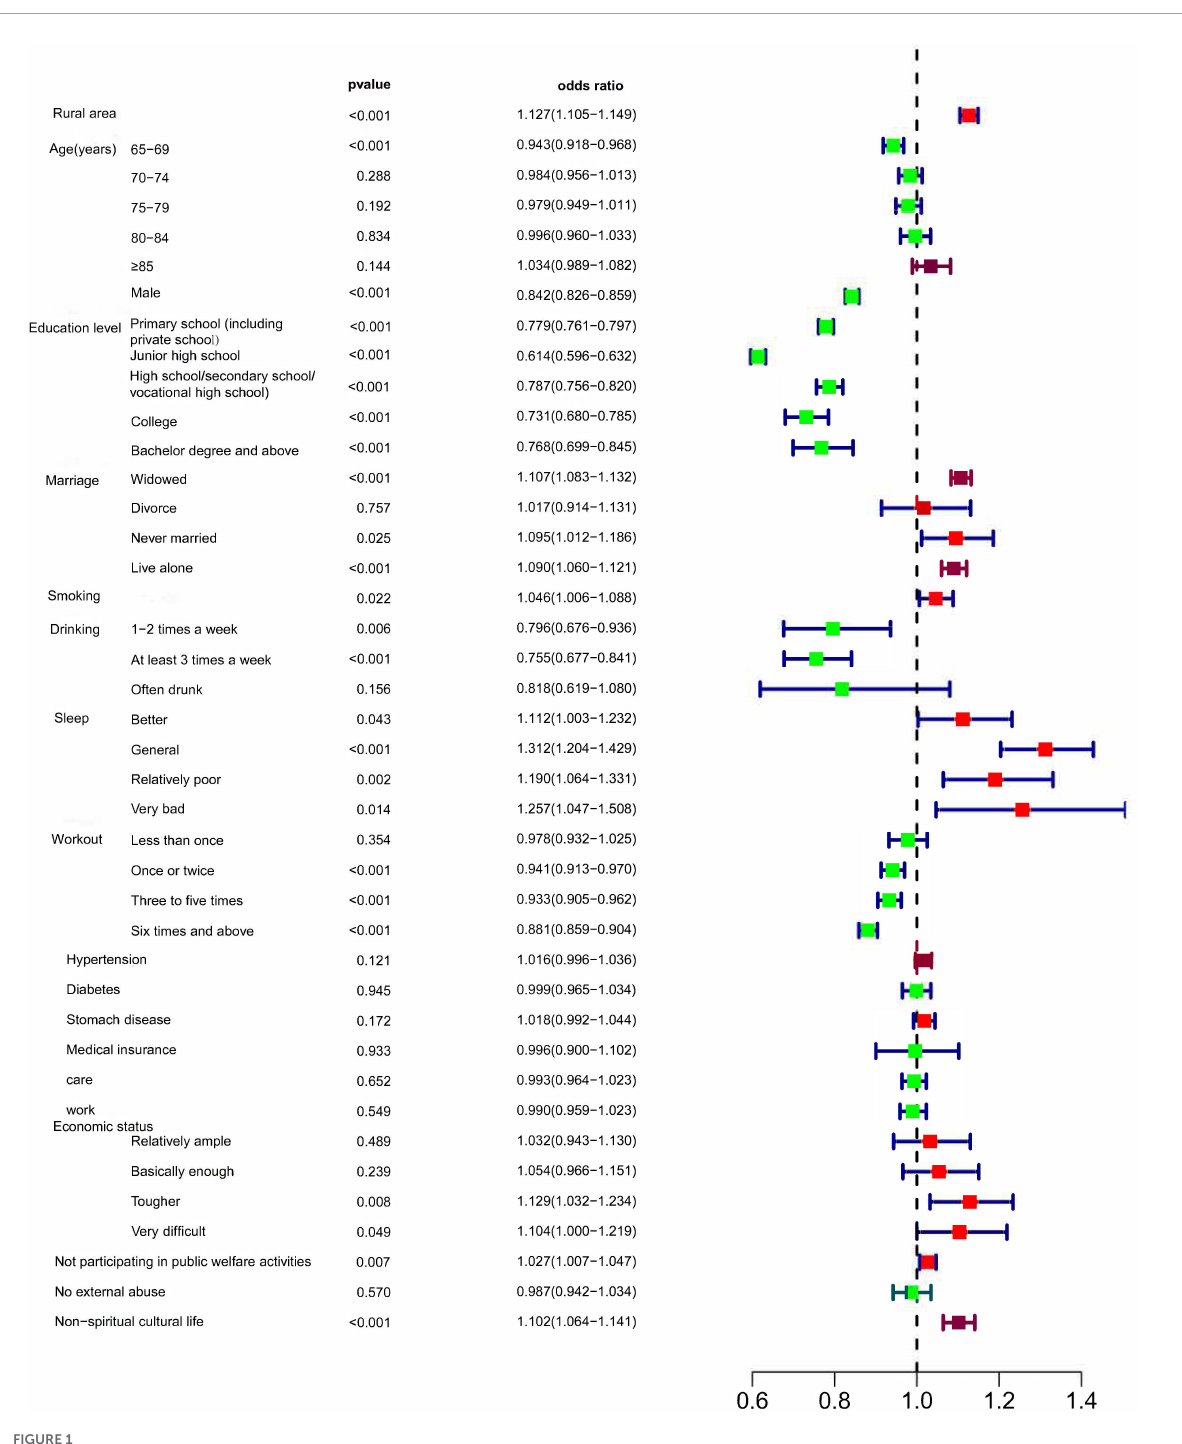
FIGURE1 Univariable logistic proportional regression analyses show associations between risk factors and CCVD.